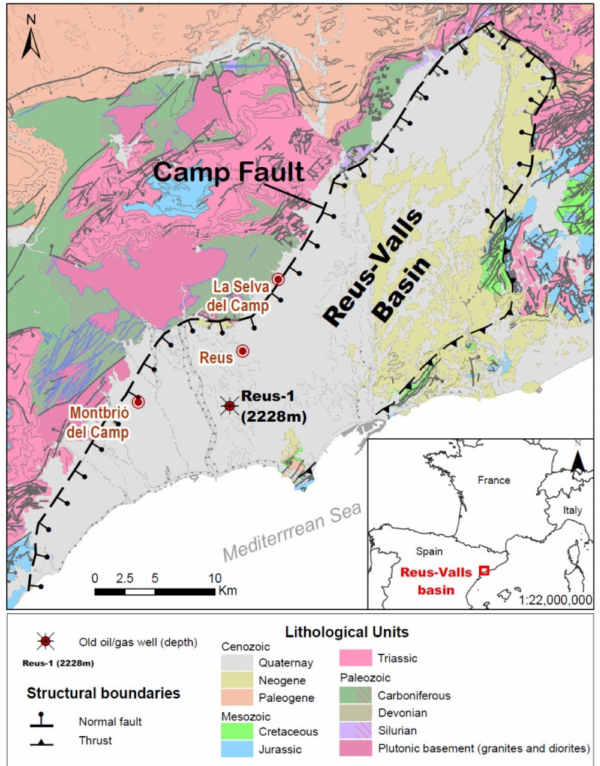
Figure 4. Geological map with the delimitation of the Reus-Valls Basin (modified from [50]). Source of EU map: © EuroGeographics for the administrative boundaries, European Commission, Euro-